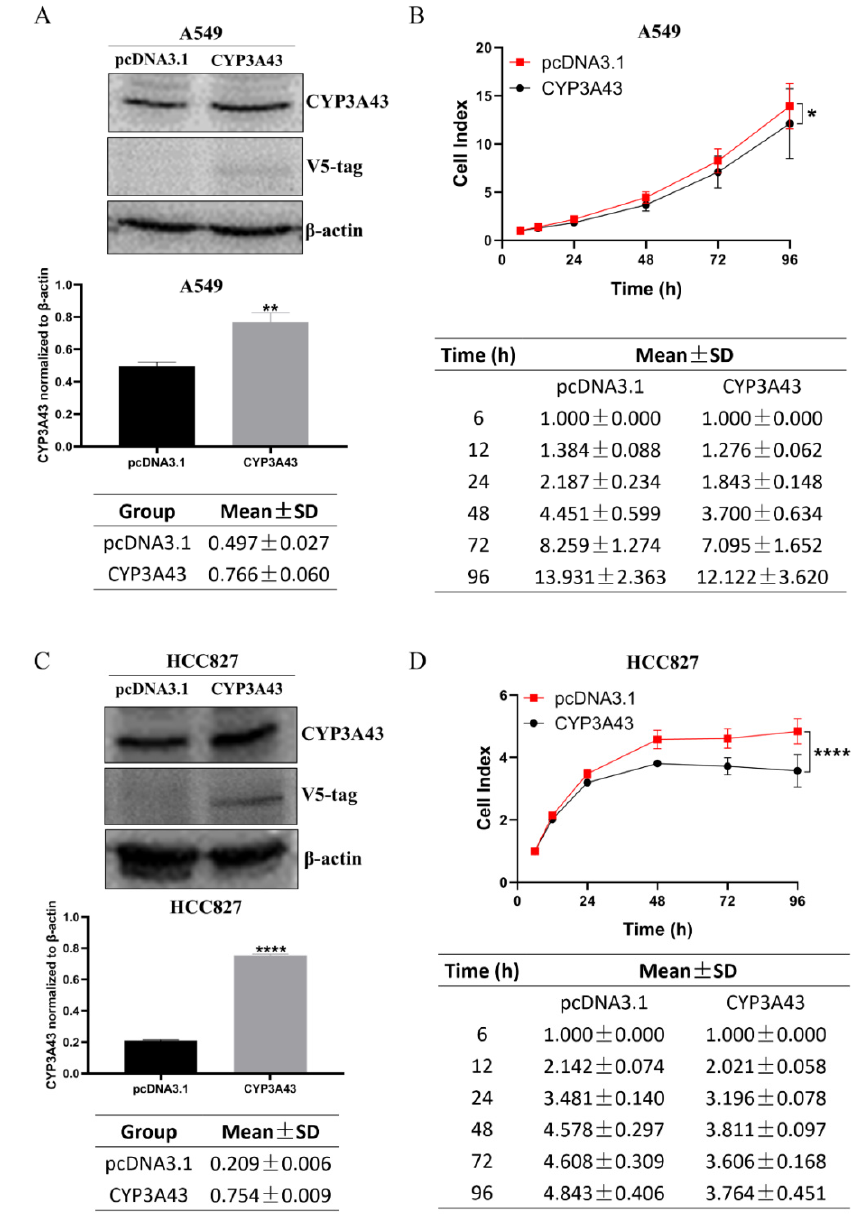
Figure 3. CYP3A43 inhibits the cell proliferation of LUAD cells. ( A , C ) The protein expression levels of CYP3A43 in A549 ( A ) and HCC827 ( C ) cells were detected after transfection with CYP3A43 plasmid for 24 h by immunoblot assay. ( B , D ) RTCA showed that the cell proliferation of A549 ( B ) and HCC827 ( D ) cells transfected with CYP3A43 plasmid was lower compared to the control cells. These results are shown as the mean ± SD, n = 3. *, p < 0.05; **, p < 0.01; ****, p < 0.0001.